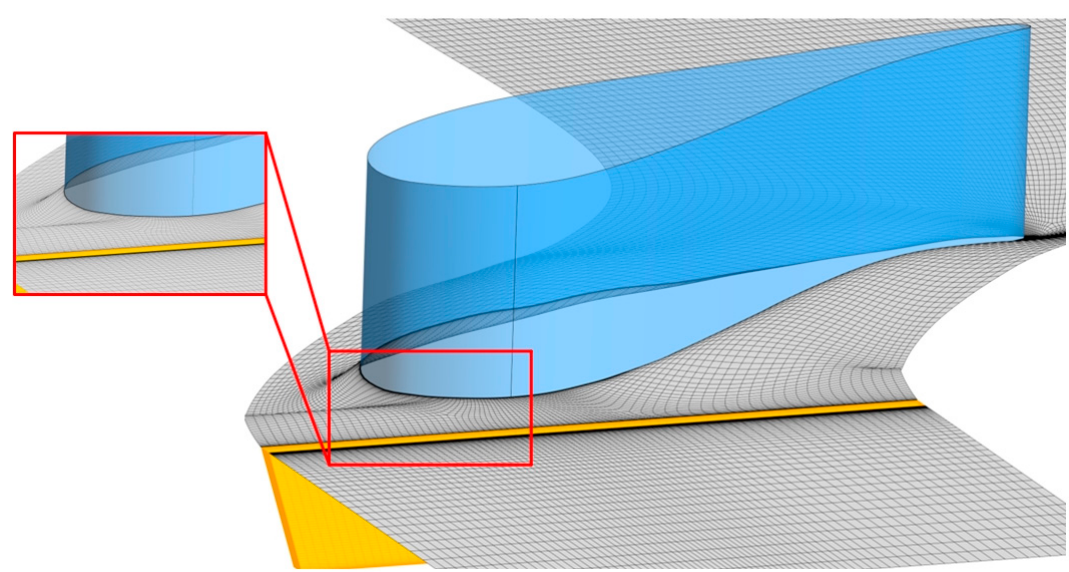
Figure 6. Computational mesh.